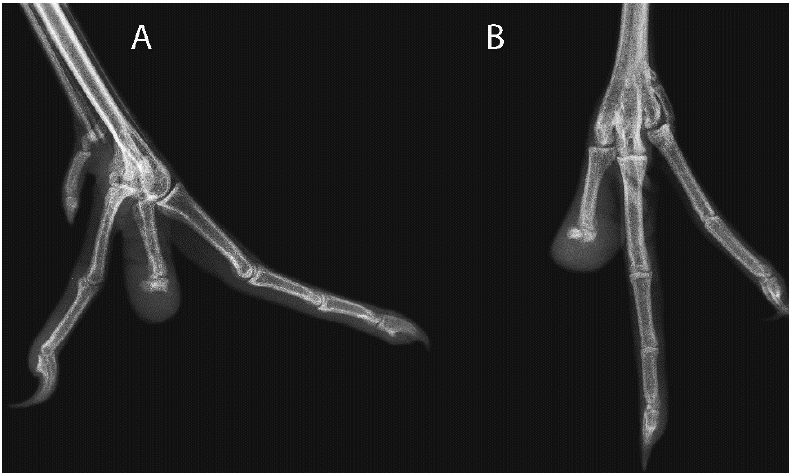
Figure 1. ( A) Lateral and ( B ) dorsoplantar radiographs of the left foot of Case 1, a 13-year-old female black-necked crane ( Grus nigricollis ) with cellulitis and probable osteomyelitis of the fourth digit of the left foot at time of presentation.